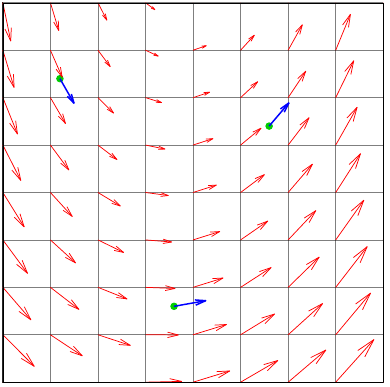
Figure 2. Vector field produced by the linear dynamic